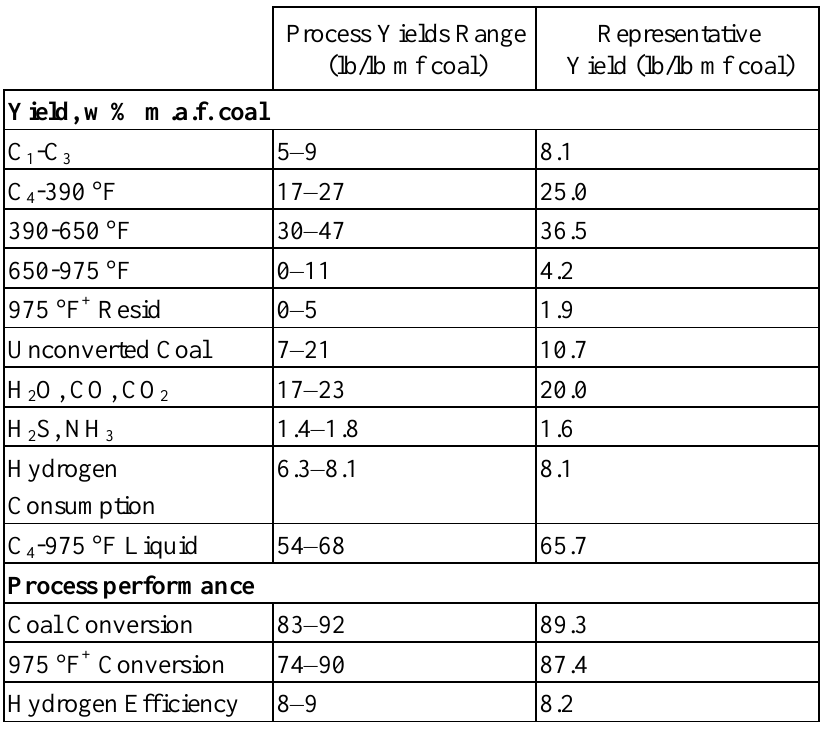
Table 13. Catalytic two-stage liquefaction process (HRI tests). Wyodak coal yields and process performance. Run 227-22.